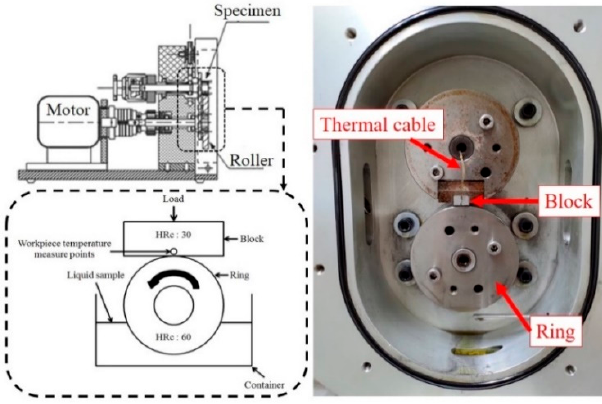
Figure 3. Schematic diagram of block-on-ring arrangement used in the friction and wear experiments.